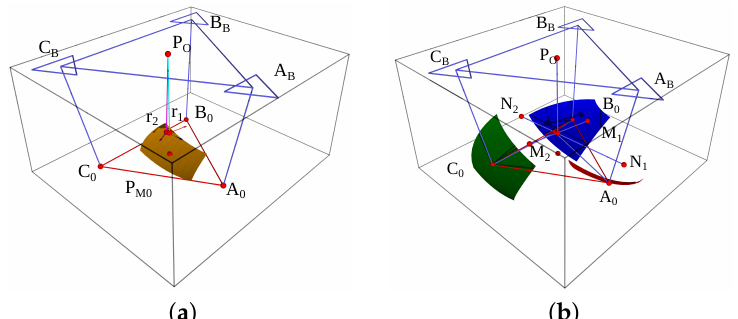
Figure 7. Geometric design: ( a ) is the platform center, base, and r 1 , r 2 ; and ( b ) platform vertices with talocrural and subtalar axis.